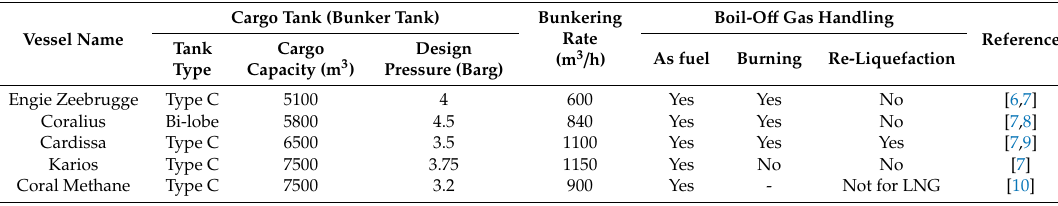
Table 1. List of liquefied natural gas (LNG) bunkering